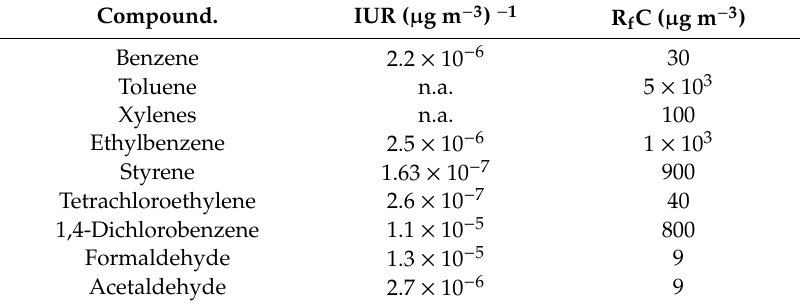
Table 2. Toxicity parameters for VOCs provided by the O ffi ce of Environmental Health